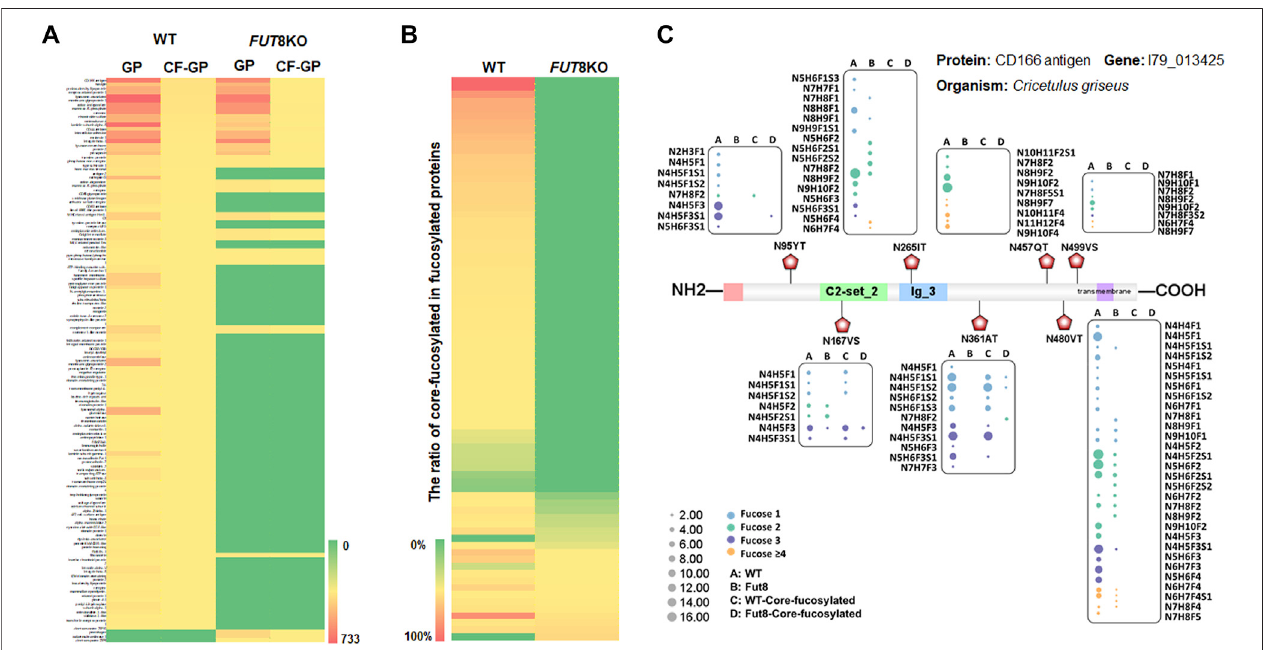
FIGURE 3 | The change of fucosylated glycoproteins in the FUT8KO CHO cells. (A) Heatmap of fucosylated and core-fucosylated glycoproteins in the WT and FUT8KOCHOcells. (B) Percentageofcore-fucosylatedglycoproteinsinfucosylatedglycoproteinsintheWTandFUT8KOCHOcells. (C) Fucosylationchangeofprotein CD166 (7 glycosites) with the FUT8KO in the CHO